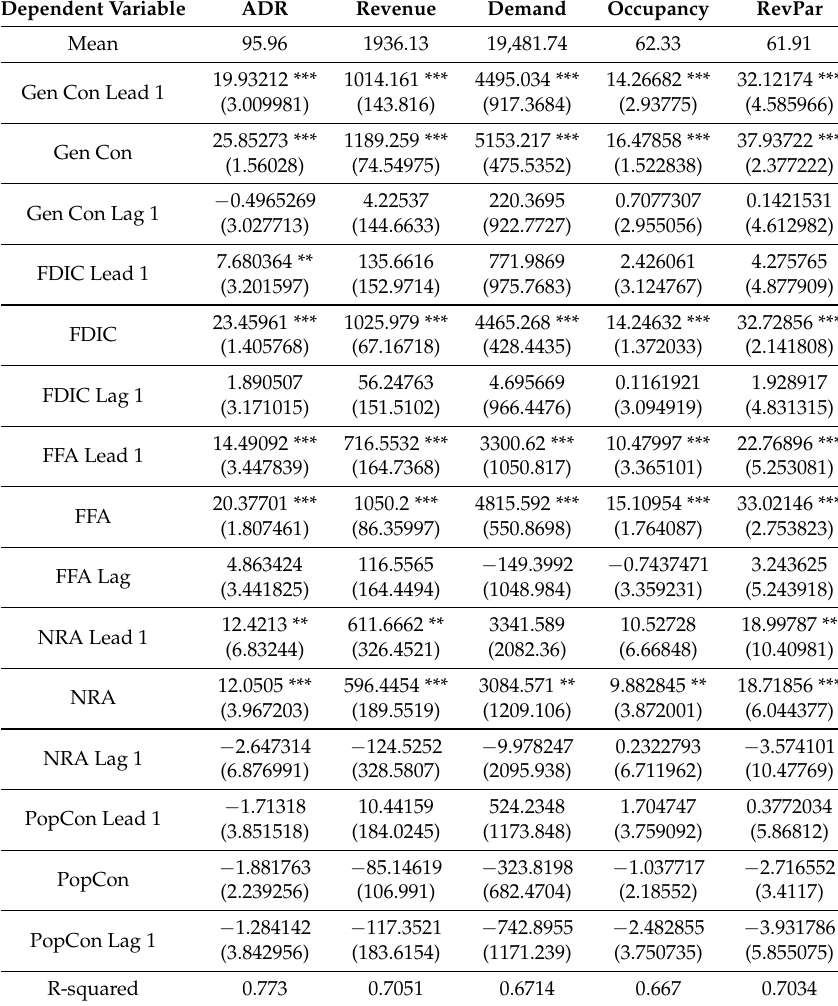
Table 6. The impact of specific conventions on the hotel